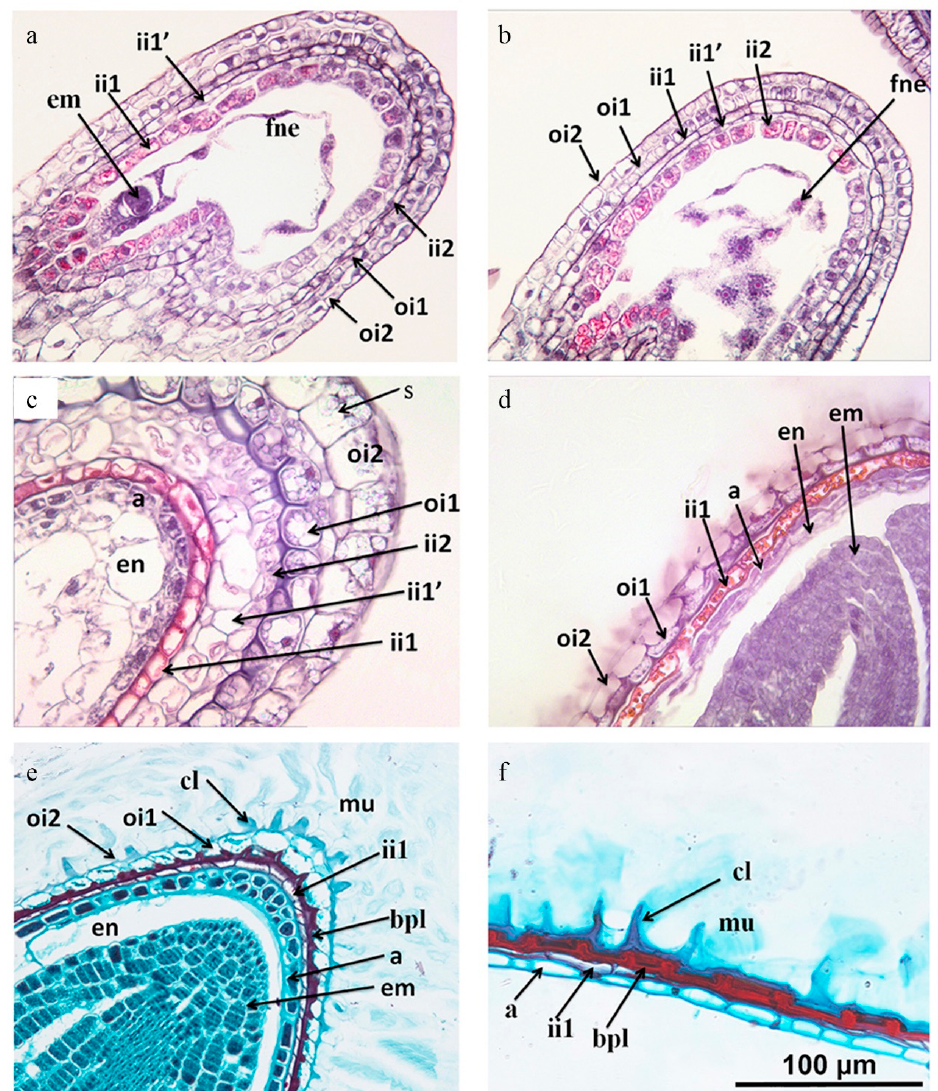
Figure 5. Longitudinal sections of developing seeds of Lepidium apetalum . ( a ) One-cell stage. ( b ) Two-cell stage. ( c ) Torpedo embryo stage, numerous starch granules appears in the layers of the outer integument, the periclinal cell wall of oil layer is thickened, aleurone layer is formed. ( d ) Bent-cotyledon stage, ii1 ′ and ii2 cells and cellular endosperm become crushed, aleurone layer becomes distinguishable, endosperm layer, except for the outermost layers, becomes gradually consumed by the growing embryo; ( e ) Mature embryo stage. The oi1 layer is still discernible by its thickened inner periclinal cell walls, forming a brown pigment layer. The oi2 layer is differentiated into the surface cell of the seed coat and the columella is formed. ( f ) Mature seeds with the oi1 layer largely crushed. a, aleurone; bpl, brown pigment layer; cl, columella; em, embryo; en, endosperm; fne, free nuclear endosperm; ii, inner integument; ii1, inner epidermis of inner integument; ii1 ′ , median layer of inner integument; ii2, outer layer of inner integument; mu, mucilage; oi, outer integument; oi1: inner epidermis of outer integument; oi2, outer epidermis of outer integument; s, starch grain.